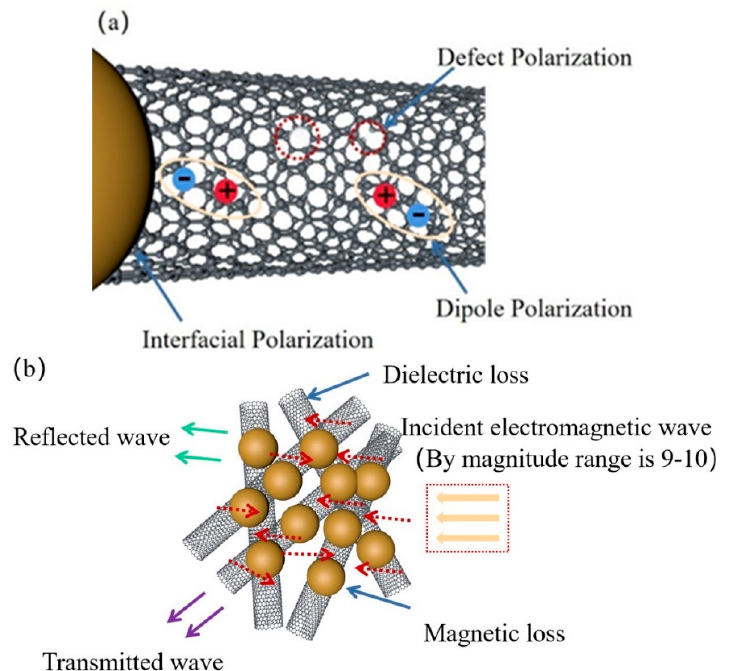
Figure 12. Schematic illustration of EM wave absorption mechanisms for CoFe 2 O 4 /SWCNTs com- posites: ( a ) relaxation loss; ( b ) absorbing mechanism.